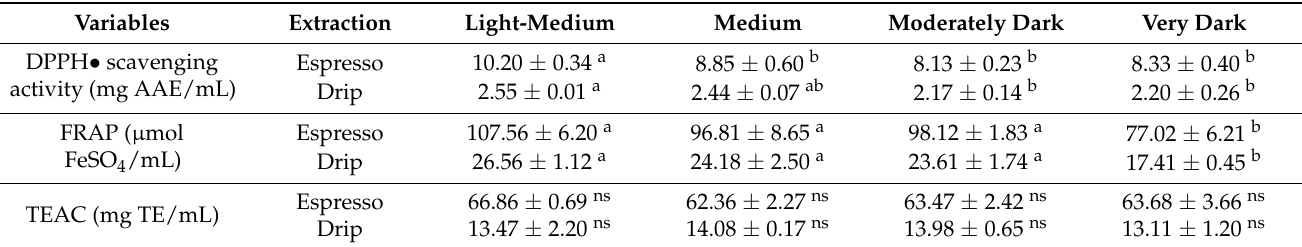
Table 5. TEAC, DPPH radical scavenging activity, FRAP of coffee